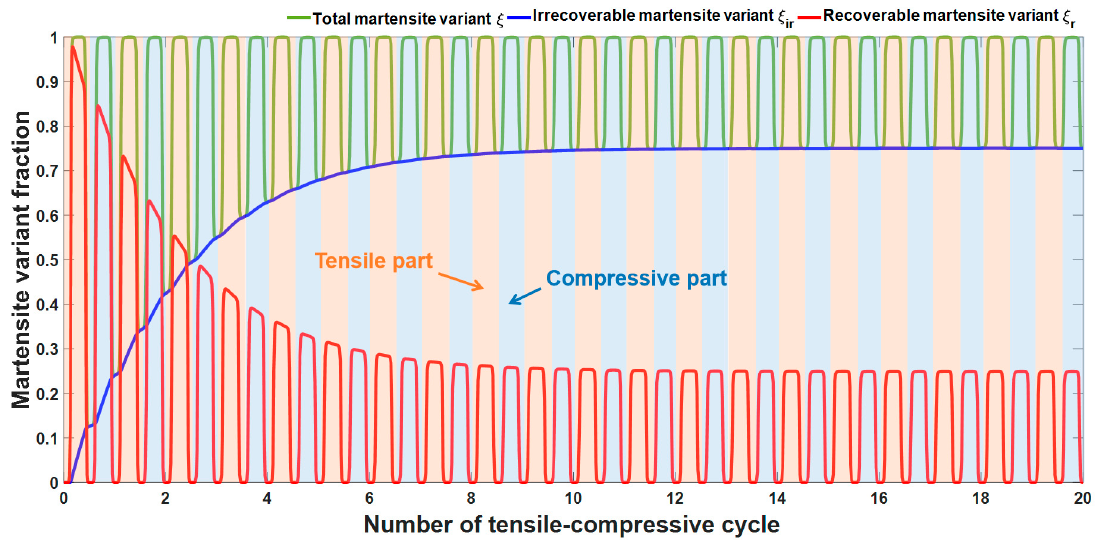
Figure 3. Variations in the martensite variants in SMAs during tensile-compressive cycles (the cycles start with a tensile